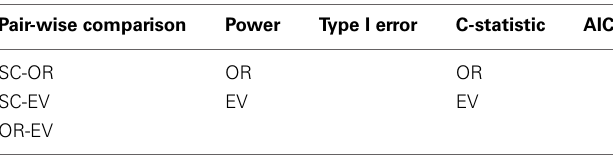
Table 2 | Significant winner ∗ in pair-wise method comparisons in terms of power, type I error, C-statistic and